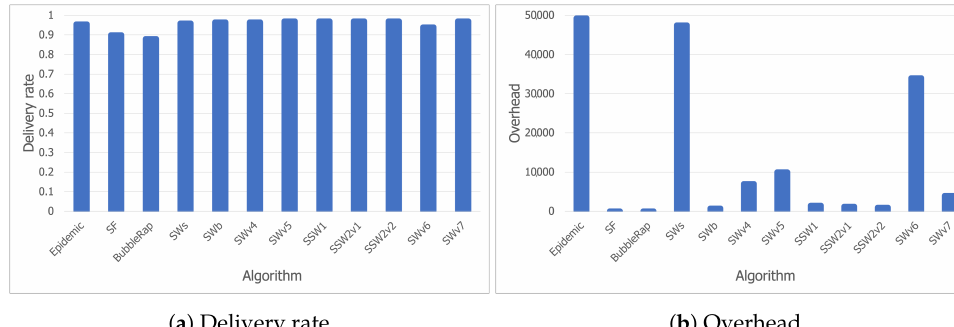
Figure 10. Delivery rate and overhead for the Wi-Fi Direct trace.